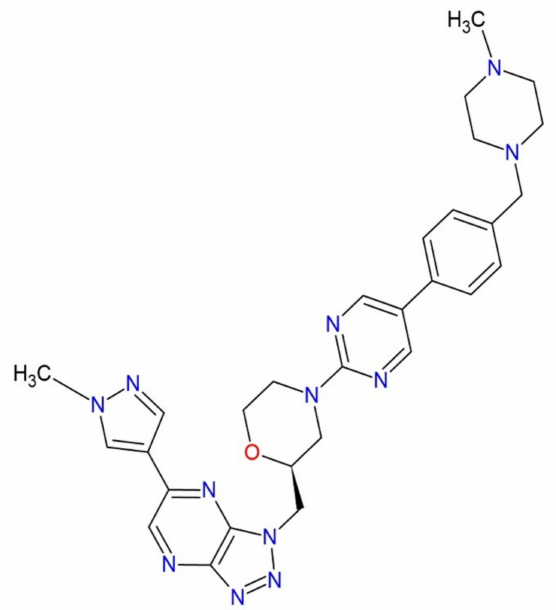
Figure 1. Chemical structure of